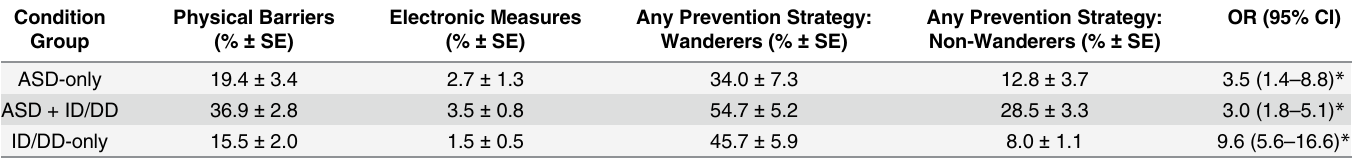
Table 7. Preventive Measure Use by Condition Group.